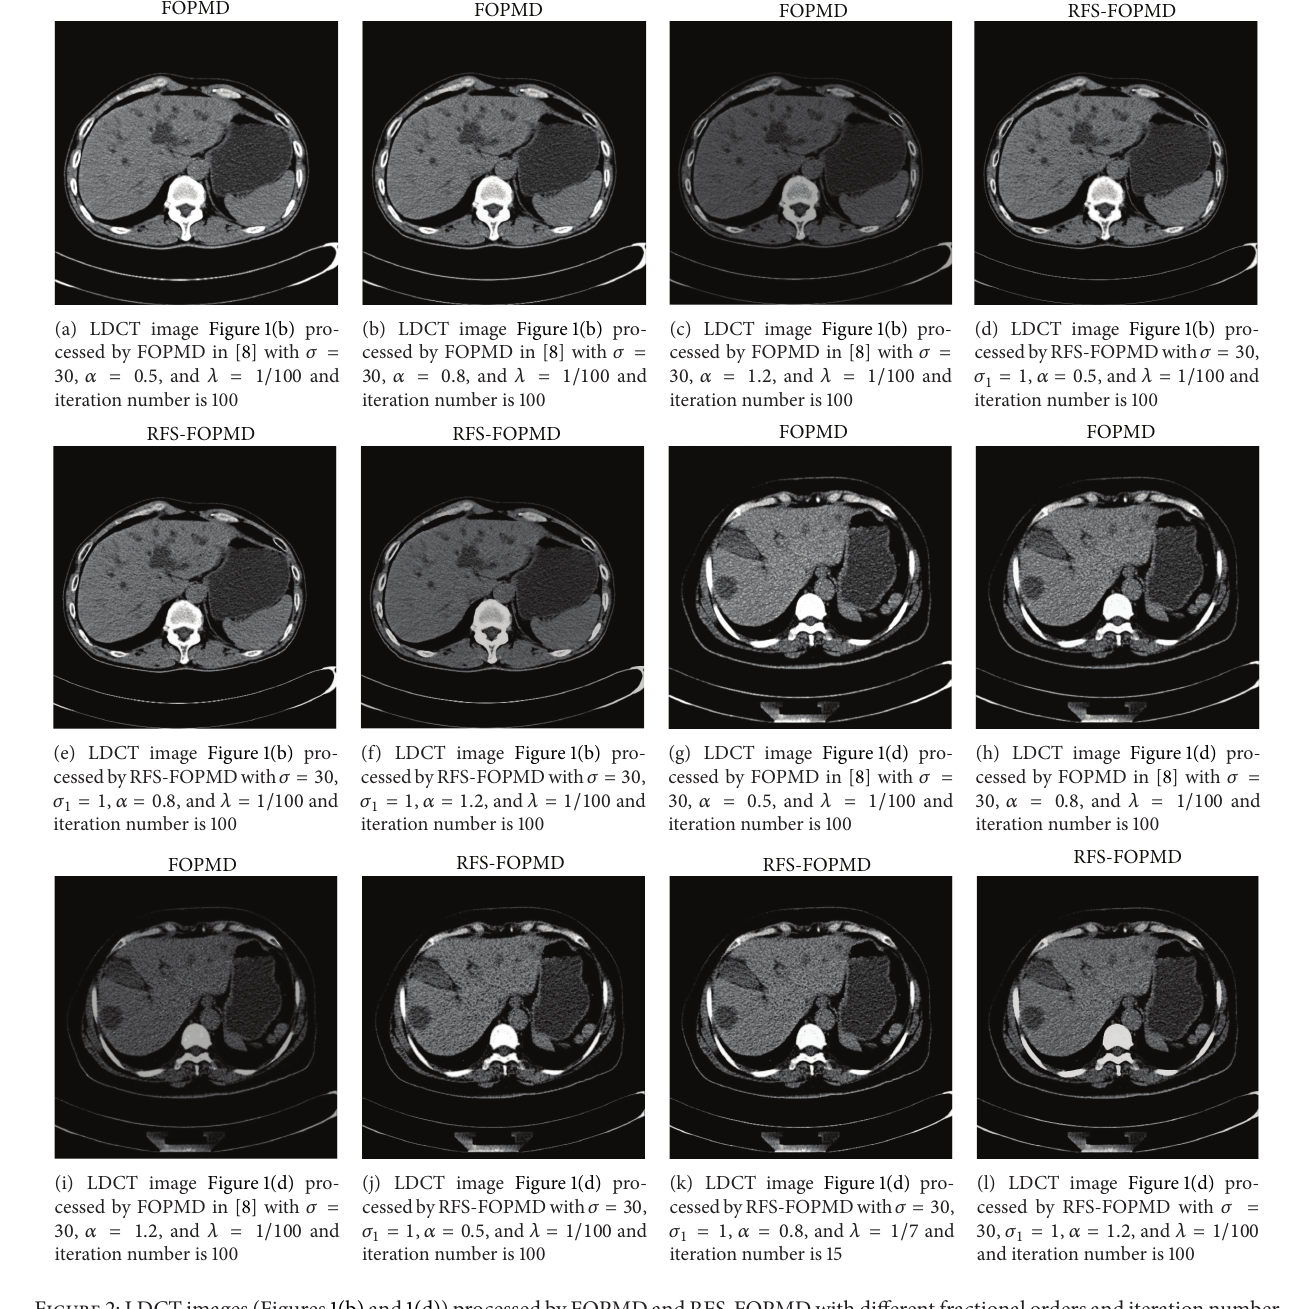
Figure 2: LDCT images (Figures 1(b) and 1(d)) processed by FOPMD and RFS-FOPMD with different fractional orders and iteration number is set to 100. The first column: 𝛼 = 0.5 ; the second column: 𝛼 = 0.8 , and the third column: 𝛼 = 1.2 . The first row: Figure 1(b) processed by FOPMD; the second row: Figure 1(b) processed by RFS-FOPMD; the third row: Figure 1(d) processed by FOPMD, and the fourth row: Figure 1(d) processed by